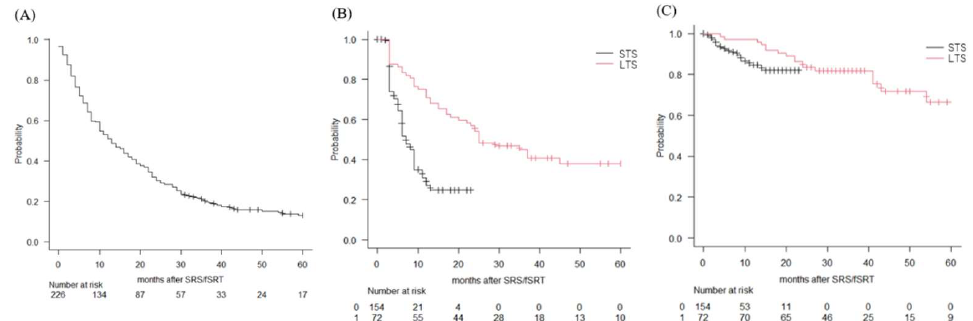
Figure 1. Treatment outcomes. Overall survival of the entire cohort of patients with brain metastases ( A ), distant failure of the STS (black line) and LTS (red line) groups ( B ), local failure of the STS (black line) and LTS (red line) groups ( C ) estimated using the Kaplan–Meier method.